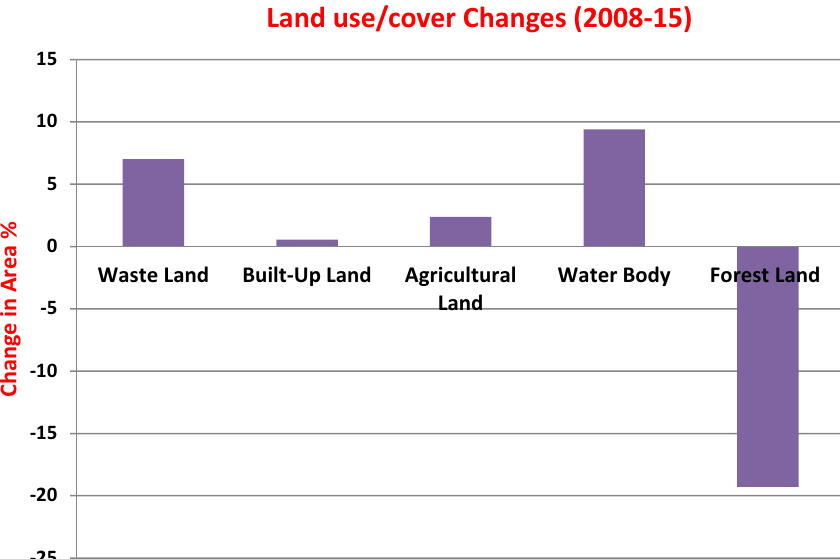
Fig. 8 Graph showing